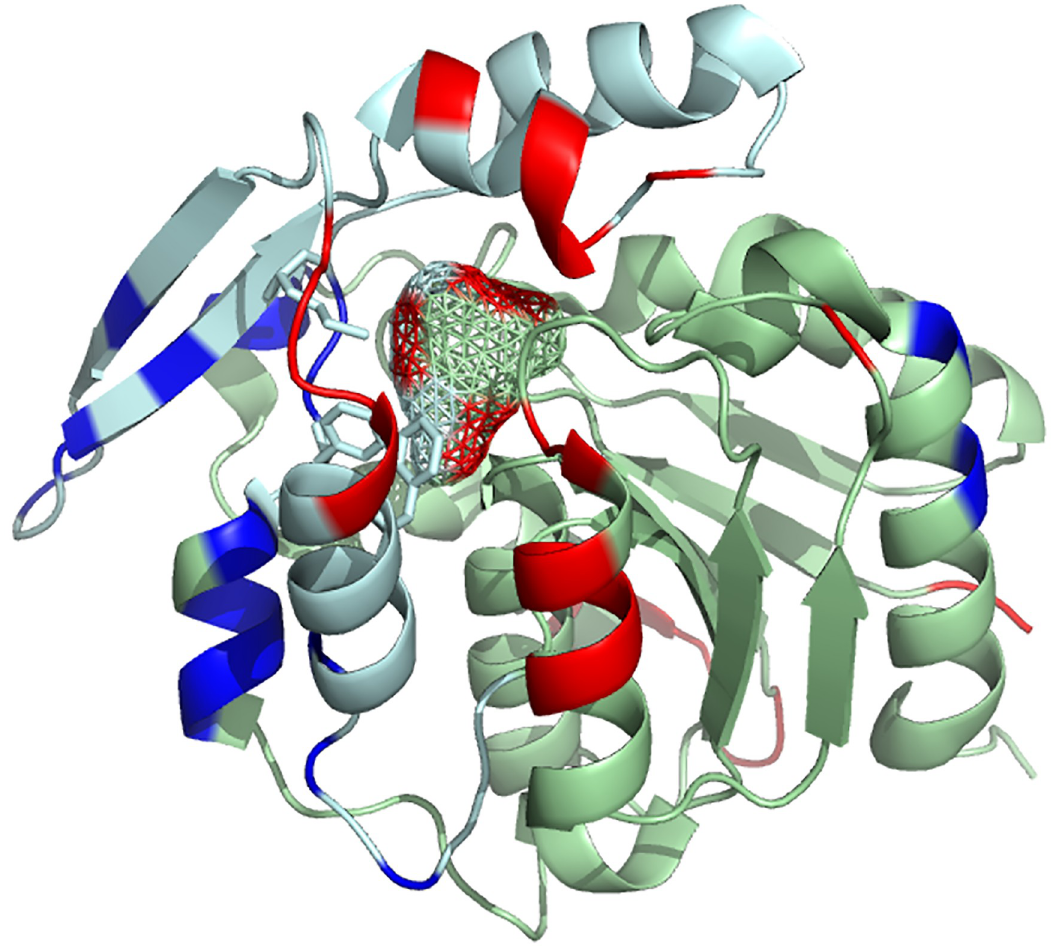
Fig 6. More flexible regions (red) of the substrate-binding site of HNL1. The flexibility differences between HNL1 (pdb id 5tdx, chain A) and Hb HNL (pdb id 1sc9) are mapped onto a cartoon representation of the HNL1 structure as indicated by differences (HNL1 minus Hb HNL) in the normalized B-factors. The light blue cartoon representation indicates the lid domain, while the light green indicates the catalytic domain. Amino acids whose C α atoms are at least one standard deviation more flexible in HNL1 than in Hb HNL are colored red, while less mobile amino acids are blue. The side chains of the three amino acids (Phe121, Met146, Phe178) responsible for the larger active site in HNL1 are shown as sticks. The mesh shows the space available for substrate binding. The projection of red color onto three regions of this mesh indicates that these three regions of the substrate-binding site are more flexible in HNL1 than in Hb HNL.